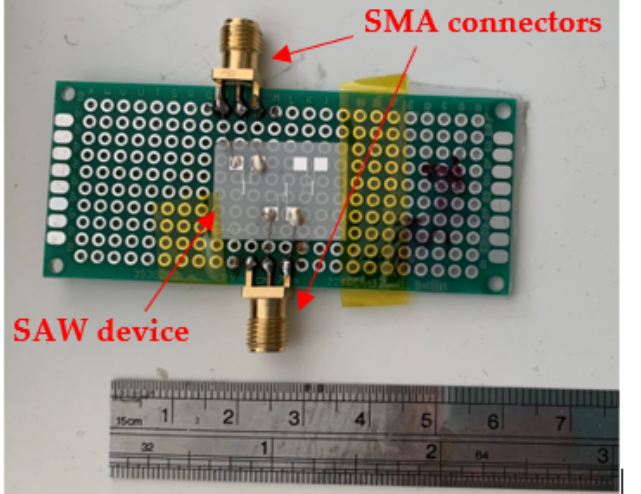
Figure 8. SAW device and its size. It uses SMA type to connect antenna and variable load board [20]. Table 1. SAW device